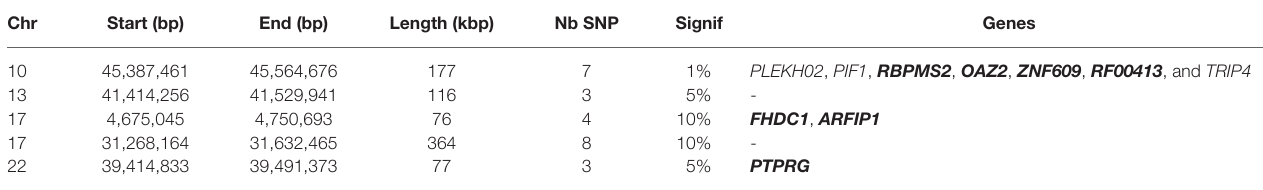
TABLE 2 | Candidate genomic regions under selection in Asturiana de los Valles since 1980, based on the HMM time series approach.